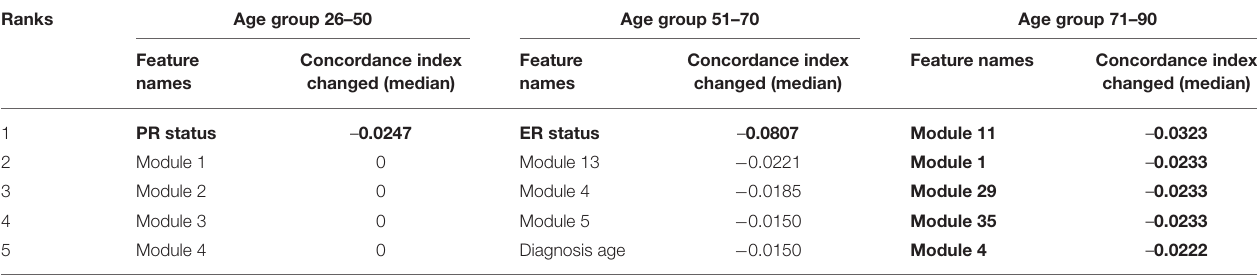
TABLE 4 | Top features that reduced the concordance indices.